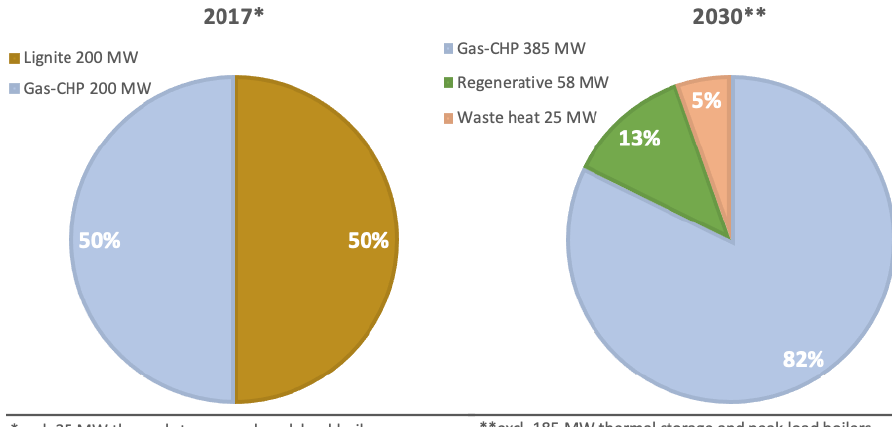
Figure 7. Projection of thermal capacity (secured power) of the district heating system in Leipzig [30]. Reproduced with permission from Leipziger Stadtwerke.